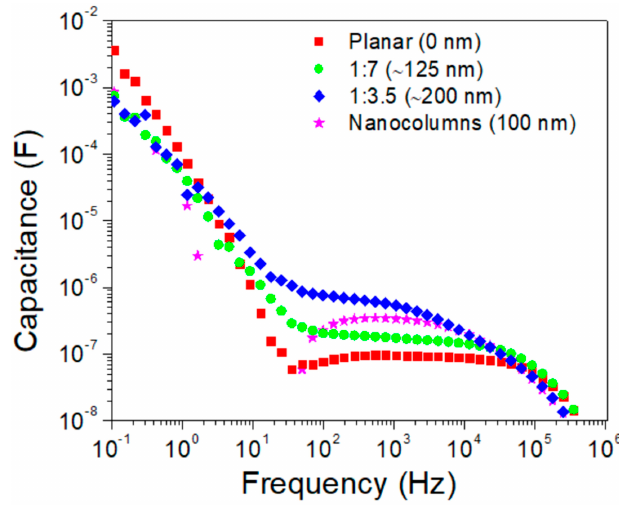
Figure 3. Frequency dependent apparent capacitance for PSCs using different electron selective layer at 0.9 V.